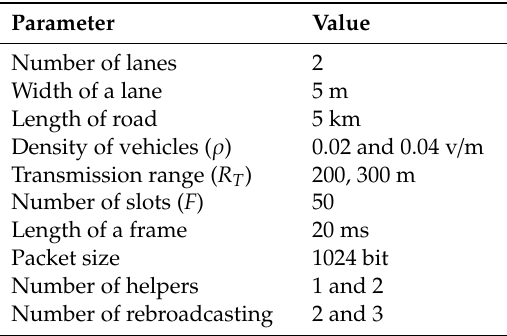
Table 1. Simulation